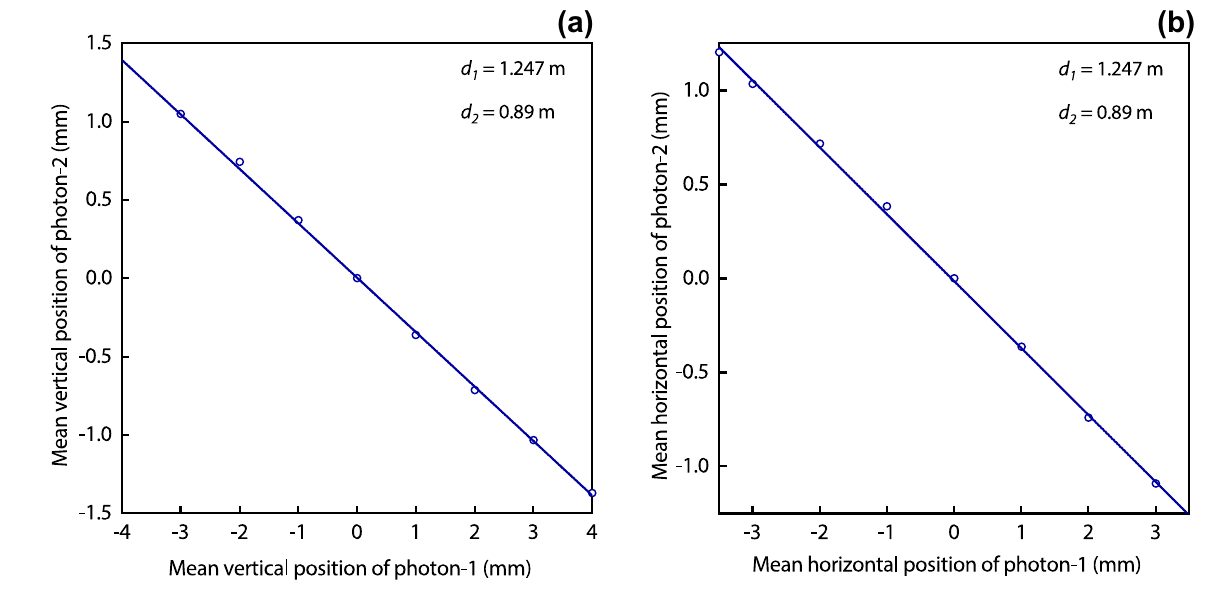
Figure 7. ( a ) Vertical position measurements of photons. Each vertical position of photon-1 is measured by passing it through a horizontally aligned single narrow slit placed in front of a lens L o . A corresponding position of photon-2 is measured by the ICCD camera in the plane of the spatial light modulator. Each data circle represents mean vertical positions of photons corresponding to a particular position of a single slit. A straight line is a linear fit which shows that vertical positions of photons are equal and opposite at equal distances from the BBO crystal. ( b ) Horizontal position measurements of photons when narrow single slit is aligned vertically and displaced horizontally. A straight line is a linear fit which shows that horizontal positions of photons are equal and opposite at equal distances from the BBO